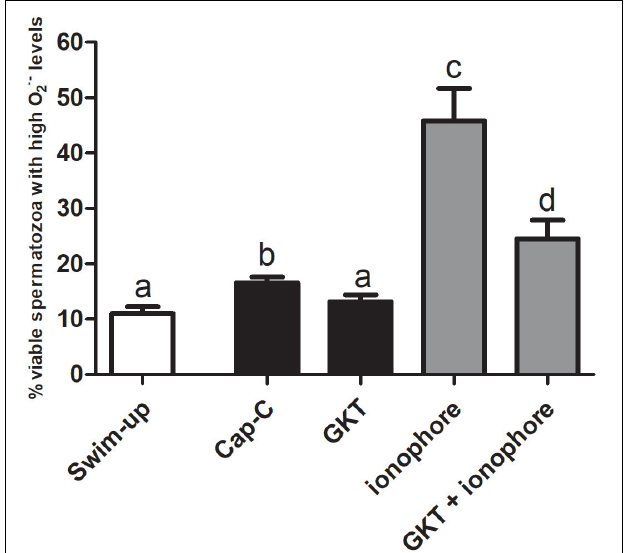
FIGURE 3 | Percentage of live spermatozoa with high superoxide levels (Yo-Pro-1–/E+) assessed by flow cytometry before (swim-up, white bars) and after in vitro capacitation with cAMP-elevating agents (Cap-C, black bars) and with GKT136901 (GKT, 1 µ M) or/and calcium ionophore A23187 (ionophore, 1 µ M, gray bars). Data are shown as mean ± S.E.M. ( n = 6). Different letters indicate significant differences ( p < 0.05).